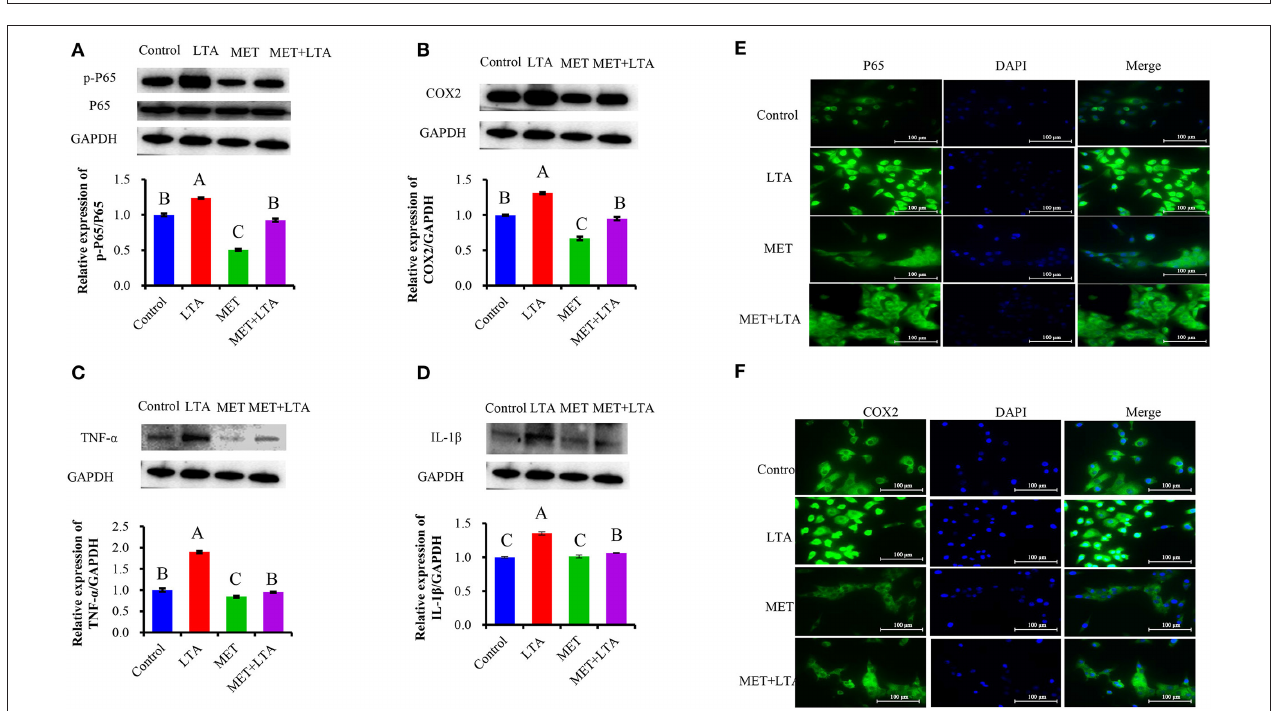
FIGURE 4 | Anti-inflammatory effect of metformin pretreated cells followed by LTA challenge. The expression of NF- κ B–signaling related proteins was measured by Western blot analysis in bovine PBMECs pretreated with 3mM metformin for 12h and challenged with 100 µ L/mL LTA for 6h. The study measured NF- κ B p65 (A) , COX2 (B) , IL-1 β (C) , and TNF- α (D) , the expression level in the whole-cell lysates. GAPDH was used to normalize the protein expression. Immunofluorescence analysis for NF- κ B p65 and COX2 (FITC) was performed, and the nuclear was stained with dye DAPI (blue). (E, F) Immunoblots and acquisition of intensity from the respective blots. Western blots shown are the representative image of three independent experiments. LTA, lipoteichoic acid; MET, metformin. Different uppercase letters (A–C) on the top of bars indicate significant differences ( n = 3, p < 0.05) among the groups.